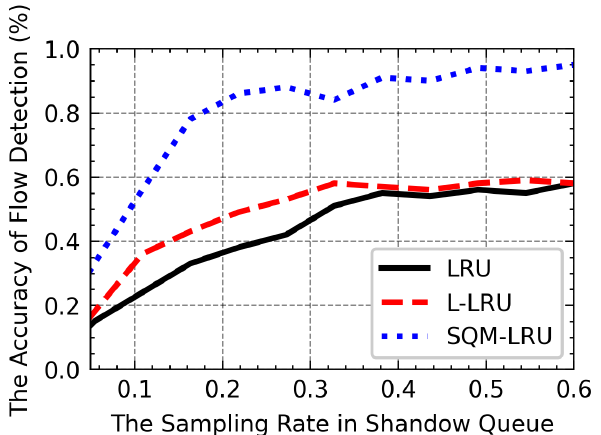
Figure 19. The influence of p samp on